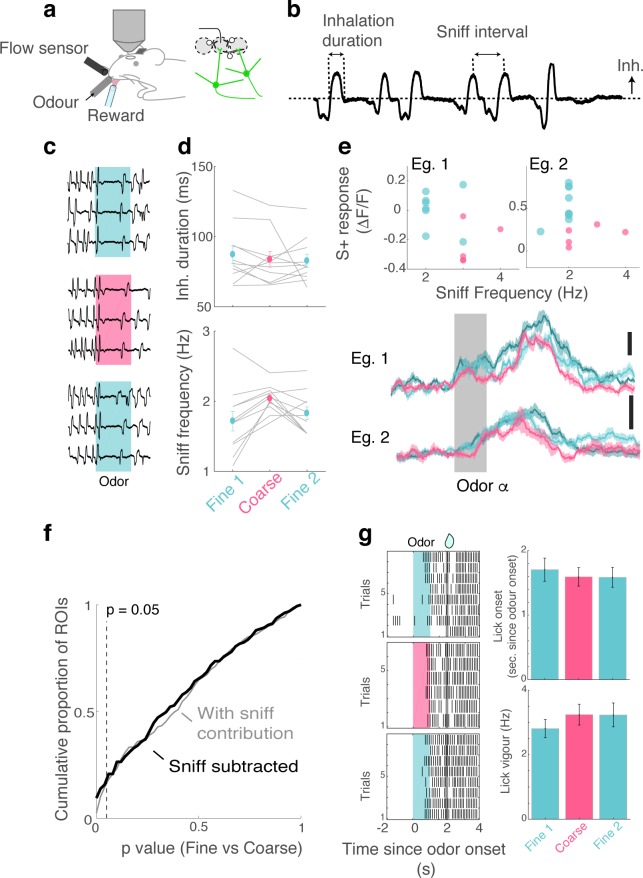
Movement and sniff patterns do not contribute to task-dependent differences.(A) Experimental setup. A flow sensor was placed in close proximity to the right nostril to monitor respiratory rhythms while the odour was presented to the left nostril. A lick sensor was a small beam break sensor placed around a water delivery port. (B) Explanation of sniff parameters measured. (C) Example of respiratory traces around the time of odour presentation. Inhalation is plotted upwards. (D) Summary of sniffing patterns showing the average duration of inhalation (above) and the number of inhalations taken during the 1 s odour presentation (below). (E) Examples of dependence on sniff: odour-evoked response amplitudes of two example ROIs against sniff frequency for individual trials during fine discrimination (turquoise) and coarse discrimination (magenta). Average transients for the same ROIs (below). (F) Distribution of p-values where dependency on sniff frequency is eliminated thorough linear regression (fitted for rewarded odour responses during fine discrimination) in black, and overall p-value distribution where sniff contribution is not subtracted (gray). (G) Lick patterns following rewarded odour presentation. Left, Examples from one imaging session. Ticks represent occurrence of licks. Each tick represents the onset of licking, relative to the onset of odour presentation. Right, Summary showing the timing of the first lick after odour onset (above) and frequency of licking for a 3 s window before reward delivery (below).